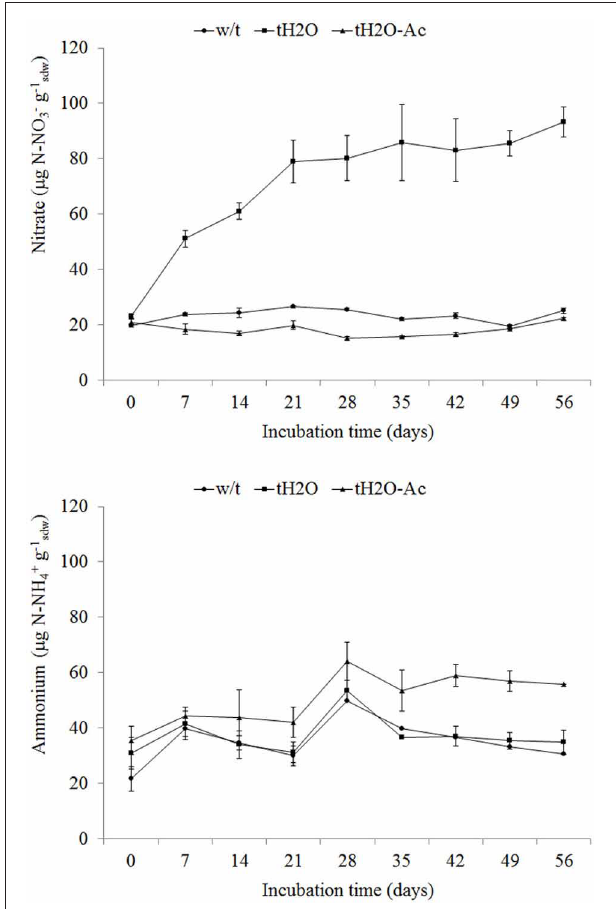
FIGURE 1 | Nitrate (upper panel) and ammonium (lower panel) concentrations (mean values; error bars represent standard deviation) in microcosms without treatment (w/t; circle), microcosms treated with water each 14 days (tH2O; square) and microcosms treated with water each 14 days and 100Pa acetylene (tH2O-Ac; triangle) during the incubation time. Nitrate concentration data of tH2O microcosms differ from those of w/t and tH2O-Ac microcosms from incubation time of 7 days ( p < 0 . 001; Bonferroni test). Ammonium concentration data of tH2O-Ac microcosms differ from those of w/t and tH2O microcosms from incubation time of 21 days ( p < 0 . 05; Bonferroni’s